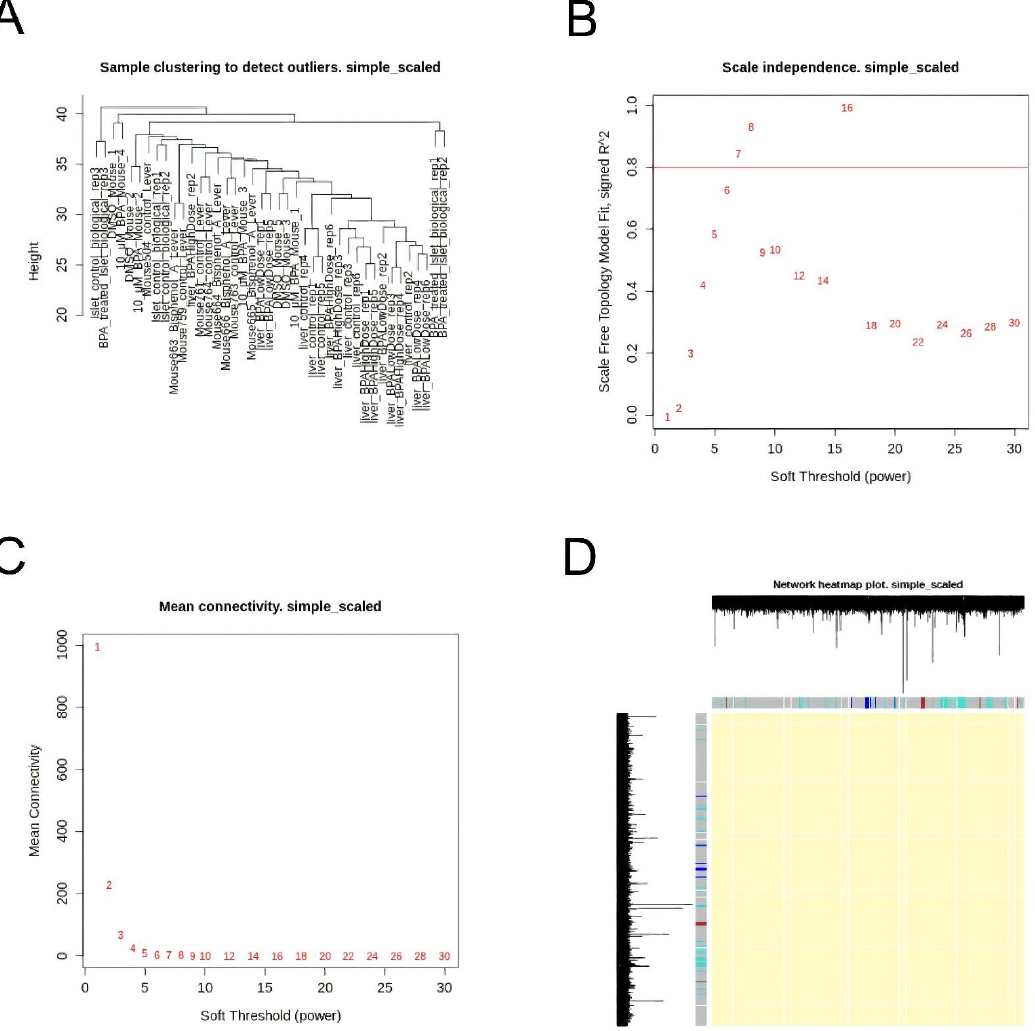
Figure 4. ( A ) Sample tree for combined dataset of GSE26728, GSE126297, GSE43977, GSE44088. Scale independence ( B ) and Mean connectivity ( C ) for combined dataset of GSE26728, GSE126297, GSE43977, GSE44088. Soft threshold is the lowest power for which the scale-free topology fit index curve flattens out upon reaching a high value. ( D ) Genes heatmap for combined dataset of GSE26728, GSE126297, GSE43977, GSE44088.